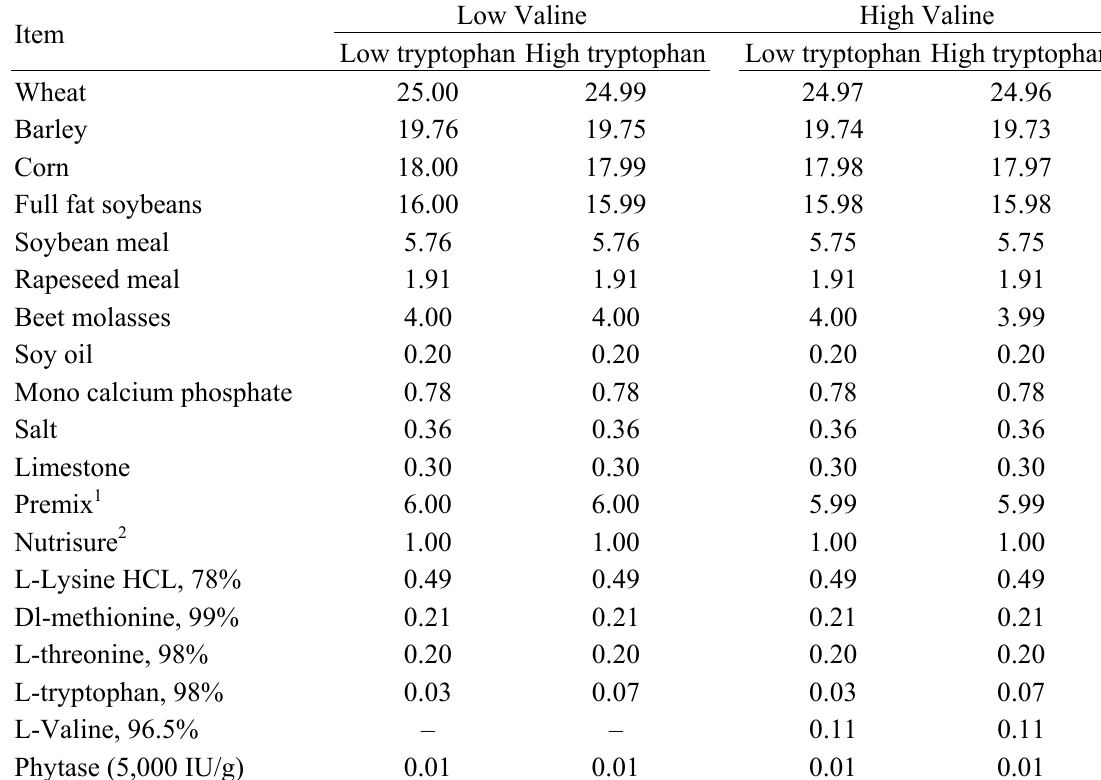
Table 1. Ingredient composition of experimental diets (%, as-fed basis).